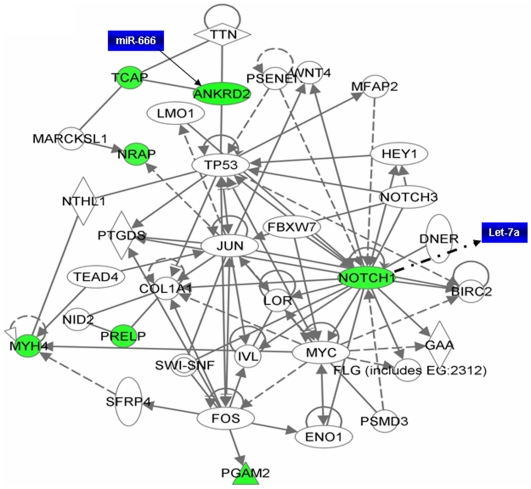
Gene network of down-regulated genes by TWEAK and their possible regulatory miRNAs.Notch1 signaling is major pathway down regulated by TWEAK in C2C12 myotubes. Genes represented in green boxes are those which were found to be significantly down-regulated in our microarray experiment. The genes shown without color are intermediate to the network and are not found in our microarray data. The solid lines connecting molecules here represents a direct relation and dotted lines an indirect relation. This network was obtained from IPA using differentially regulated genes by TWEAK with p-values ≤0.05 and ≥1.5-fold and was superimposed with the miRNAs (blue colored boxes) having their putative targets.